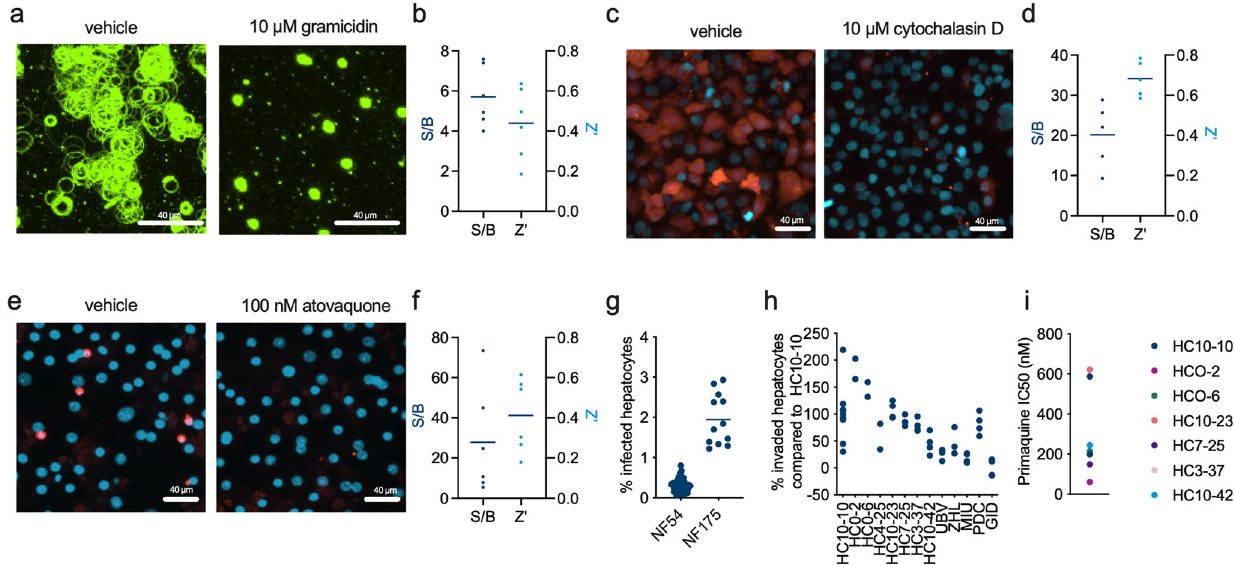
Fig. 2 Miniaturized assay formats for sporozoite function. a Micrographs of P. falciparum NF54 sporozoite gliding assays showing the difference in gliding activity between sporozoites treated with vehicle (0.1% DMSO) or 10 µ M gramicidin. Gliding activity was visualized by immuno fl uorescent staining of deposited circumsporozoite protein. b Signal to background (S/B) and Z ′ numbers as determined from independent gliding assays using high-content imaging and quanti fi cation of total fl uorescence. Each symbol represents an independent experiment, with 2 – 4 wells for each control (vehicle and gramicidin) c Micrographs of P. falciparum NF54 sporozoite traversal assays showing the difference in traversal activity between sporozoites treated